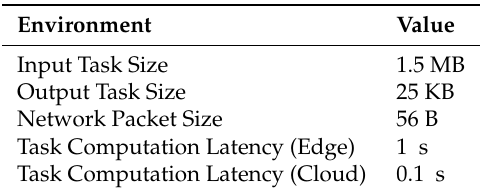
Table 2. Task environment.